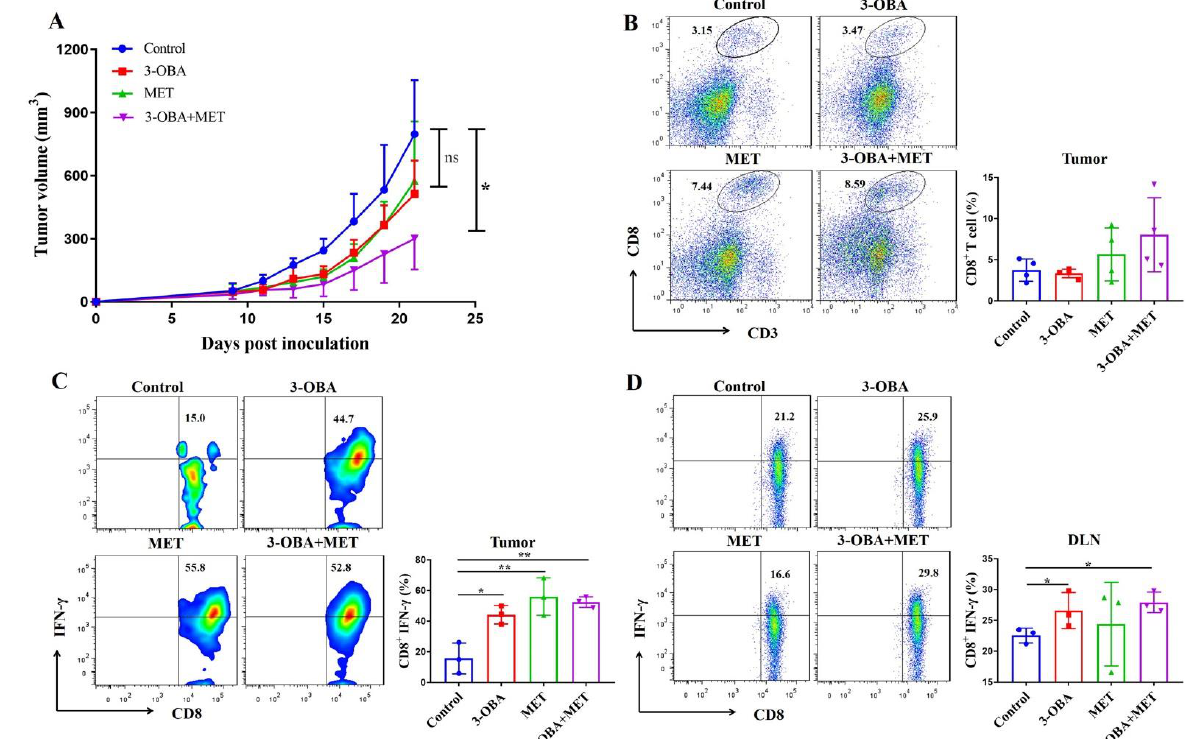
Figure 5. The combination of 3-OBA and metformin could suppress CT26 tumor cell growth and active CD8 + T cells. BALB/c mice ( n = 6) were treated with 75 mg/kg of 3-OBA, 200 mg/kg of metformin, and the combination every day. ( A ) Tumor volumes. ( B ) The ratio of intra-tumoral CD8 + T cells. ( C ) The proportion of IFN- γ + CD8 + T cells in tumors ( D ) and in the draining lymph nodes. * p < 0.05, ** p < 0.01. ns denotes no significant difference.